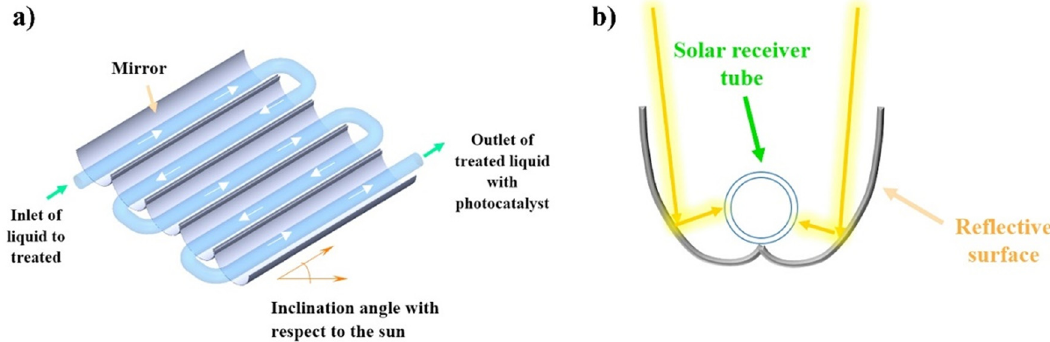
Figure 5: ( a ) Reactor with concentrated natural lighting by parabolic channel, continuous fl ow, and suspended photocatalyst. The incli - nation of the reactor depends on the system location. ( b ) Cross - sectional view of the composite parabolic collector showing the con fi g - uration of the re fl ective surface and the circular